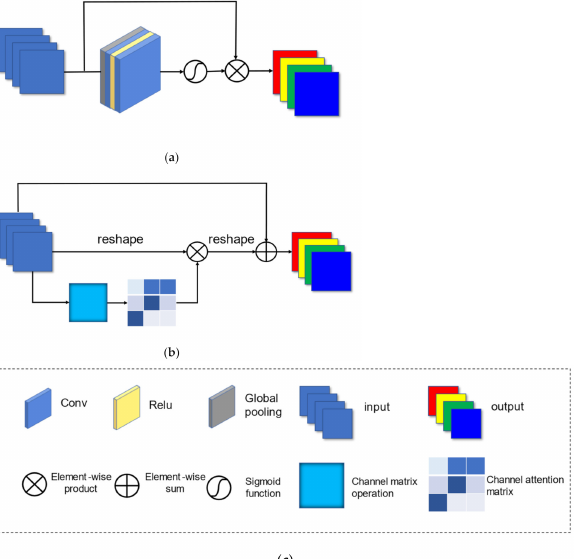
Figure 2. ( a ) Squeeze-and-Excitation Module; ( b ) Self Channel Attention Module; and ( c ) legend for composition